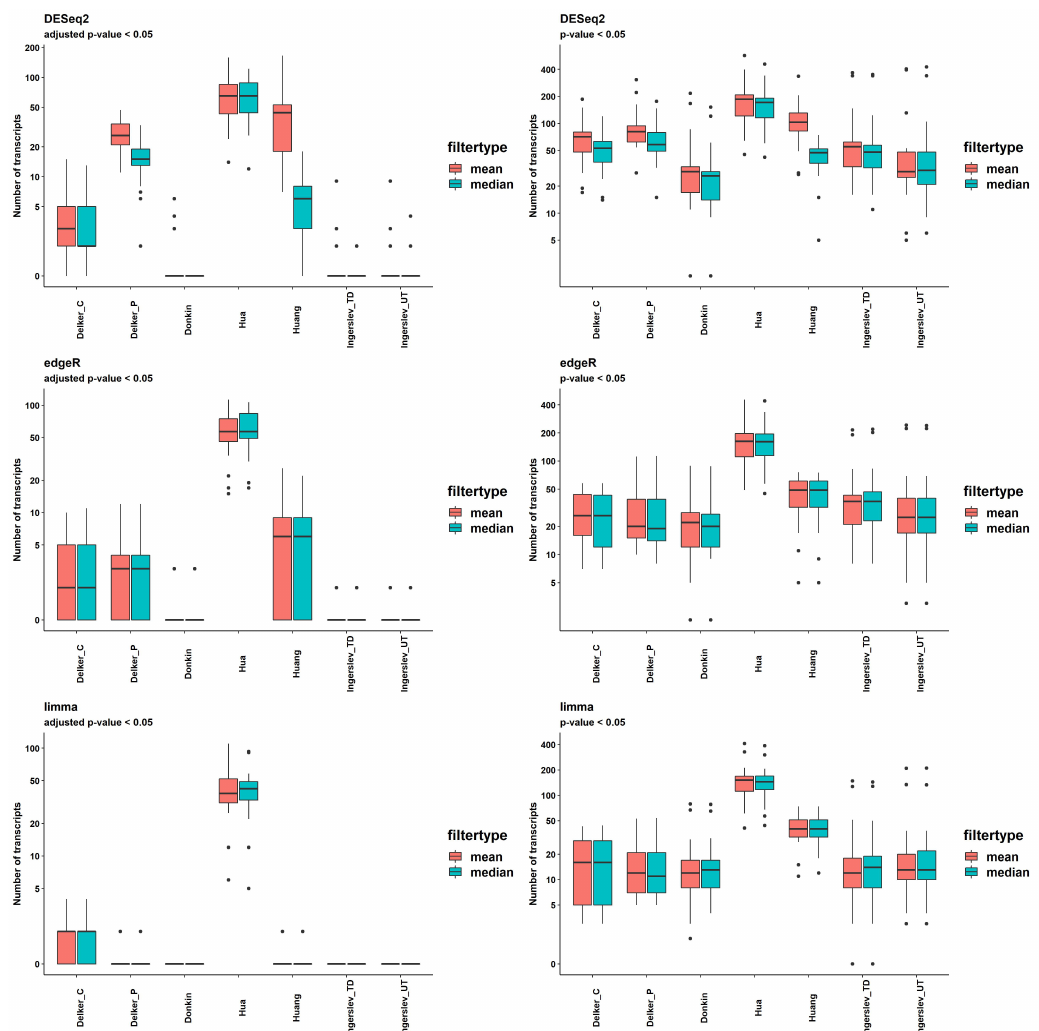
Figure 6. Number of DE transcripts provided by DESeq2, edgeR and limma with p -value or adjusted p -value < 0.05 among data [59,60,62–64] with different